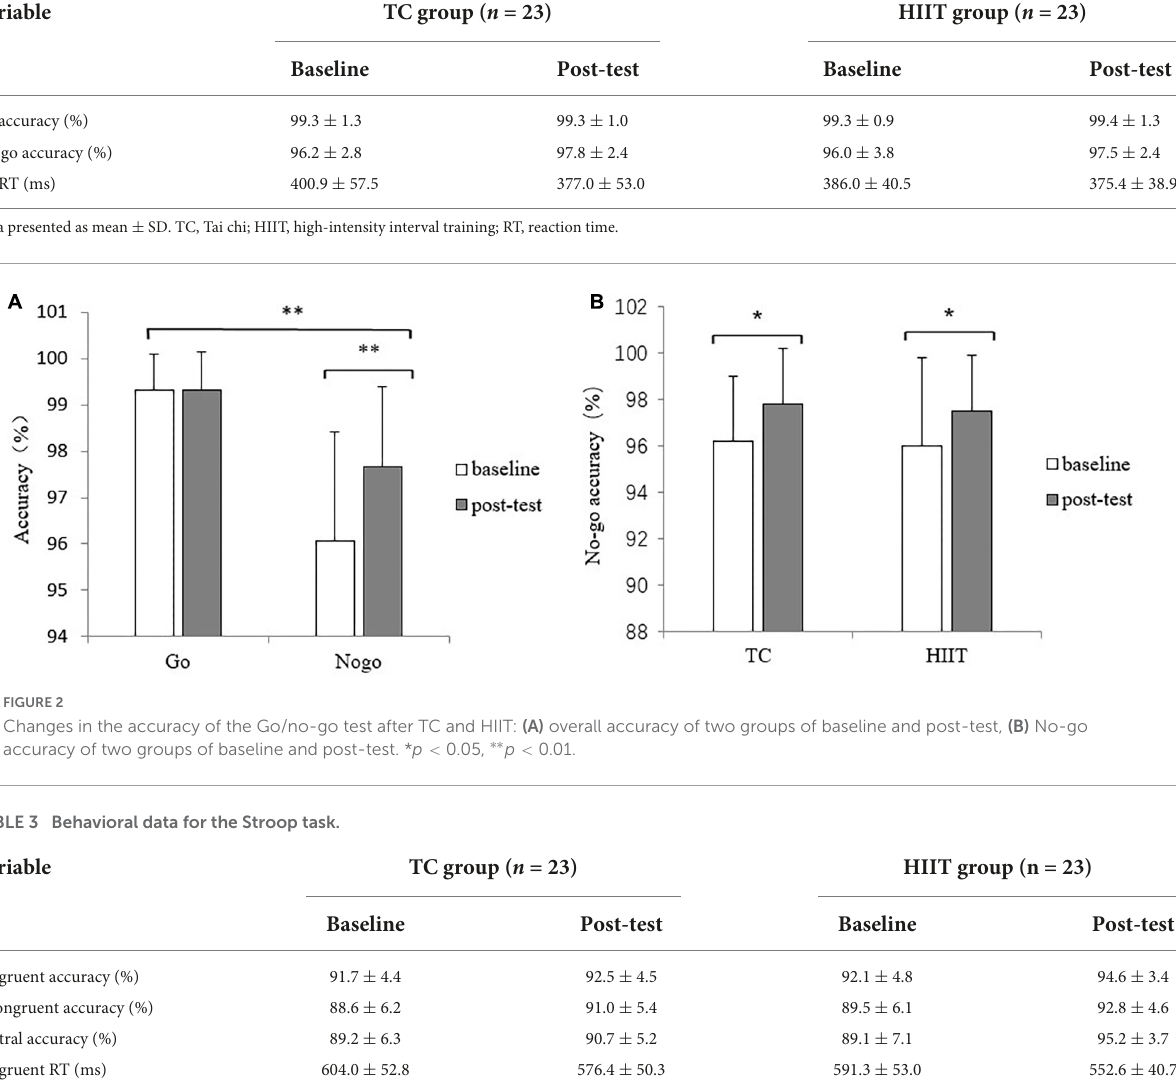
TABLE 2 Behavioral data for the Go/No-go task.